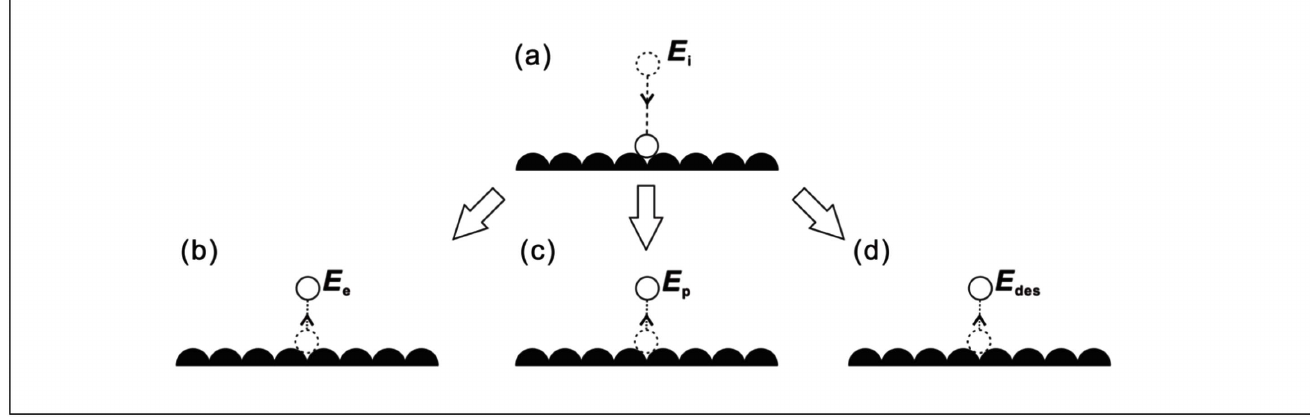
Fig 1. Energies of particles in the following states: (a) incident (b) elastic scattering (c) pre-cursor (d)